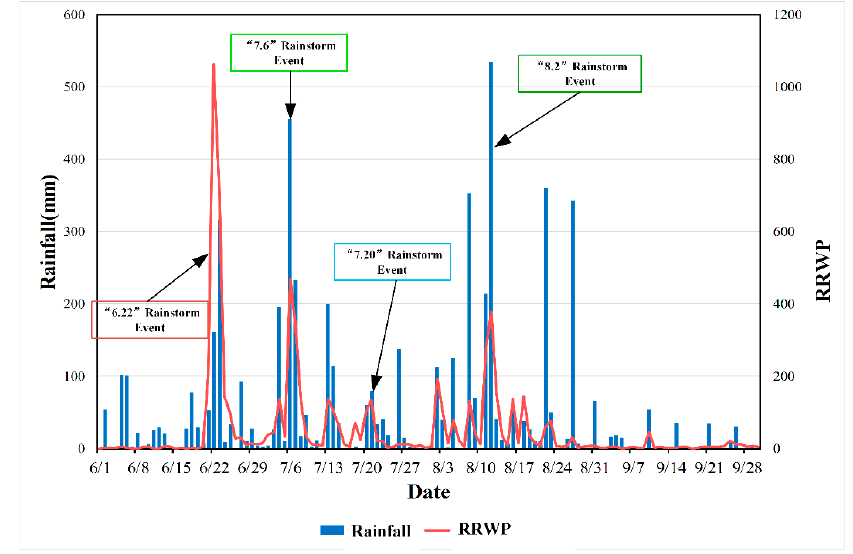
Figure 4. The time series RRWP and rainfall in Beijing from June to September 2017.